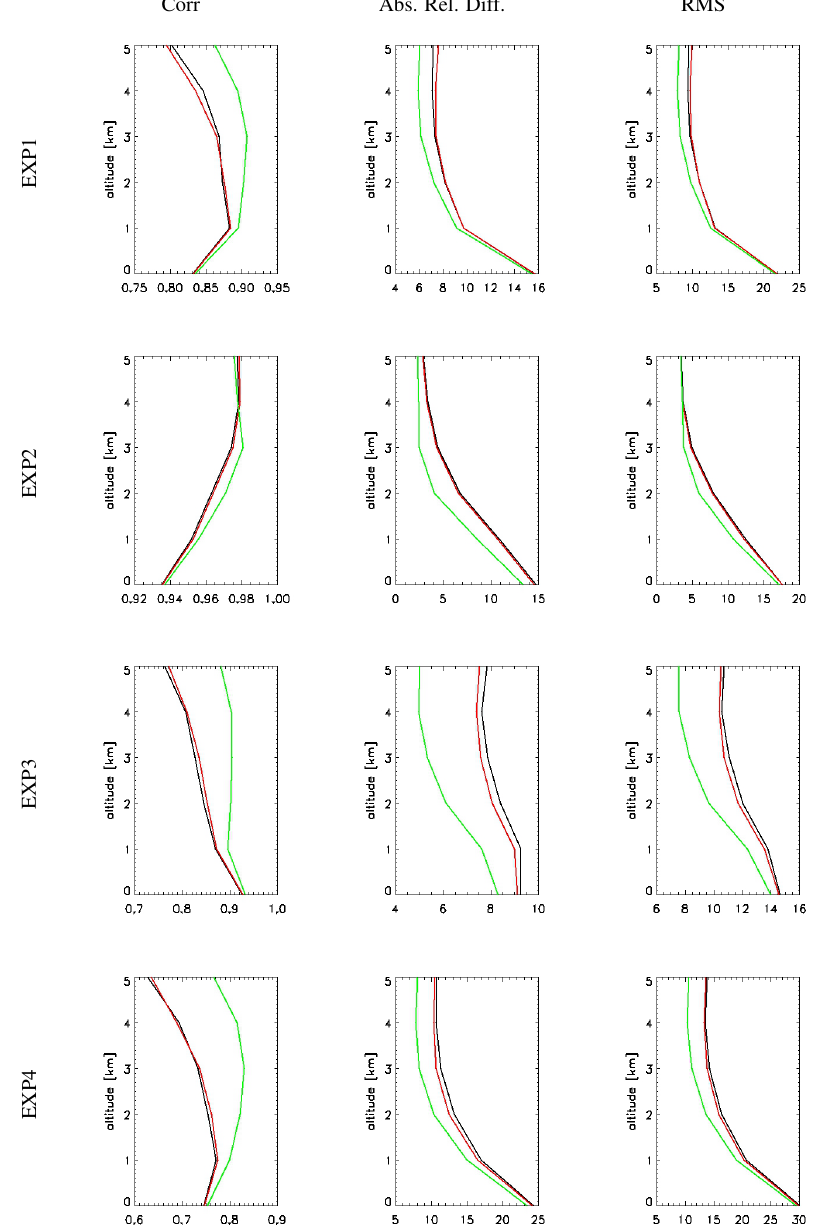
Fig. 13. Correlation (left panel), absolute relative difference in % (middle panel) and RMS difference in % (right panel) between the nature run (NR) and the control run (black); between the nature run and the assimilation run of GEO-TIR2 (red) and between the nature run and the assimilation run of GEO-TIR (green). Percentages are with respect to the nature run. The 1st row is for EXP1 (change in the meteorology), the 2nd row is for EXP2 (change in the emissions), the 3rd row is for EXP3 (change in the initial condition) and the 4th row is for EXP4 (change in the meteorology, in the emissions and in the initial condition). 42